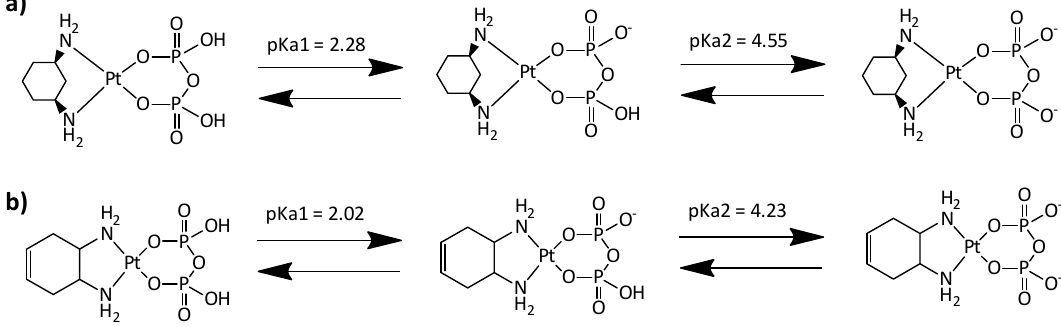
Figure 5. Plot of 31 P chemical shift vs. pH* for 1 ( a ) and 2 ( b ).